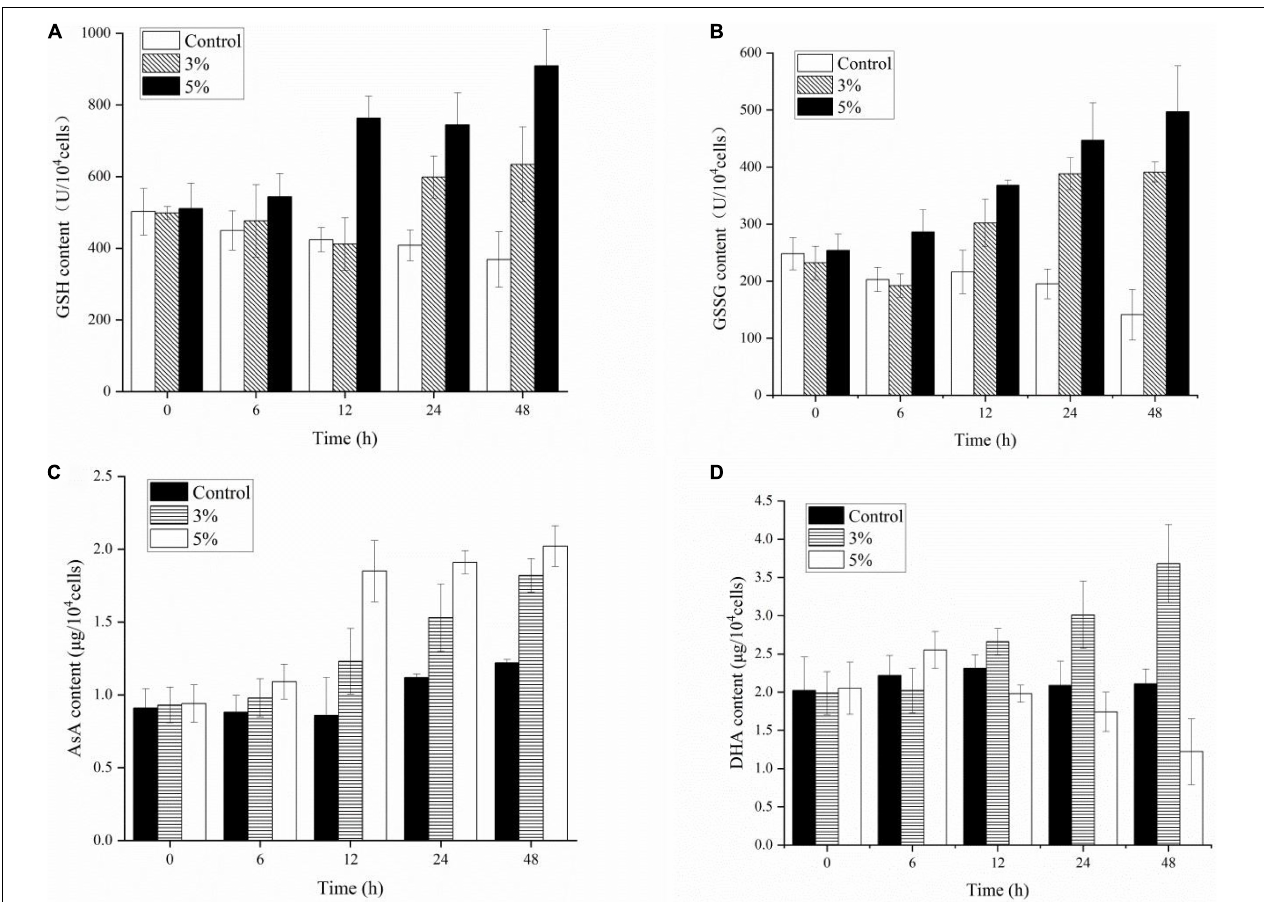
FIGURE 8 | Effects of non-enzymic antioxidants including GSH (A) , GSSG (B) , AsA (C) , and DHA (D) activities in Karenia mikimotoi after exposure to Paracoccus homiensis O-4 at different